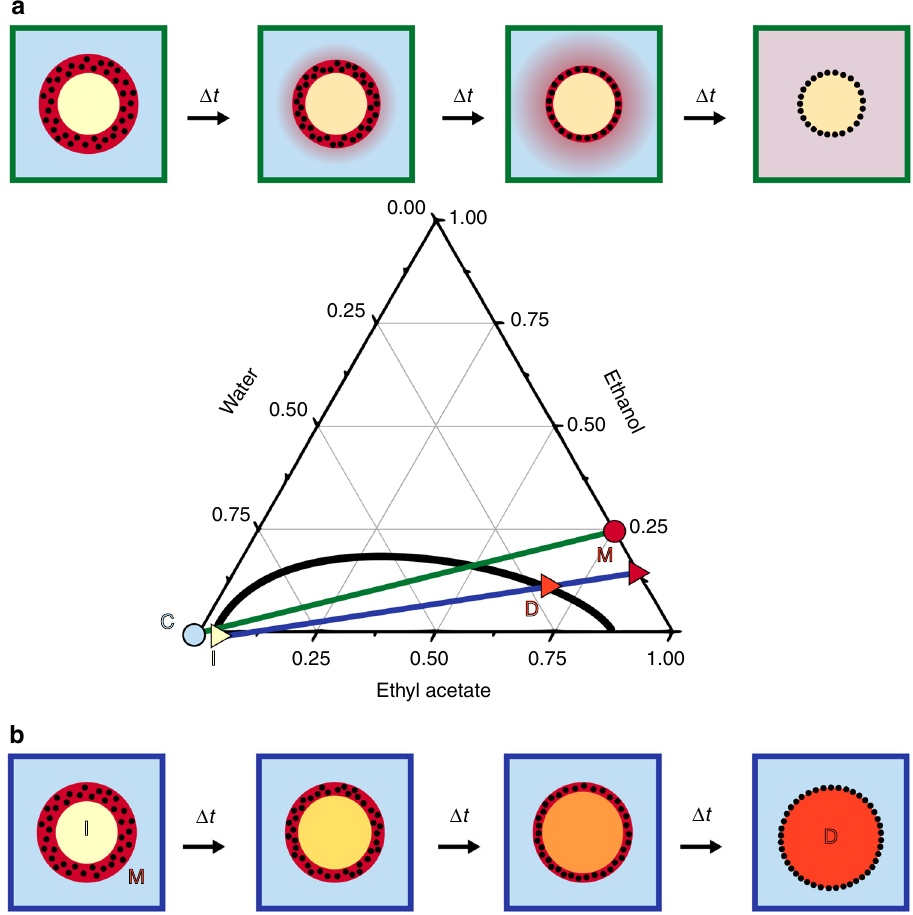
Fig. 1 Transient double emulsion approach: Schematic representation of the transient double emulsion approach, where a middle phase (M) dissolves into the inner phase (I) or into the outer phase (O), shown, respectively, above and below the phase diagram. The particles are always suspended in the middle phase. Example phase diagram for an oil-in-water emulsion where volumes are chosen in a way that the mixing point, i.e. the composition of the fi nal droplet (D), lies on the binodal curve. For the green schematic a , water is used as the outer phase (C) and an inert oil is the inner phase (not shown on the diagram)), for the blue schematic b an inert oil is used as the outer phase (not shown on the